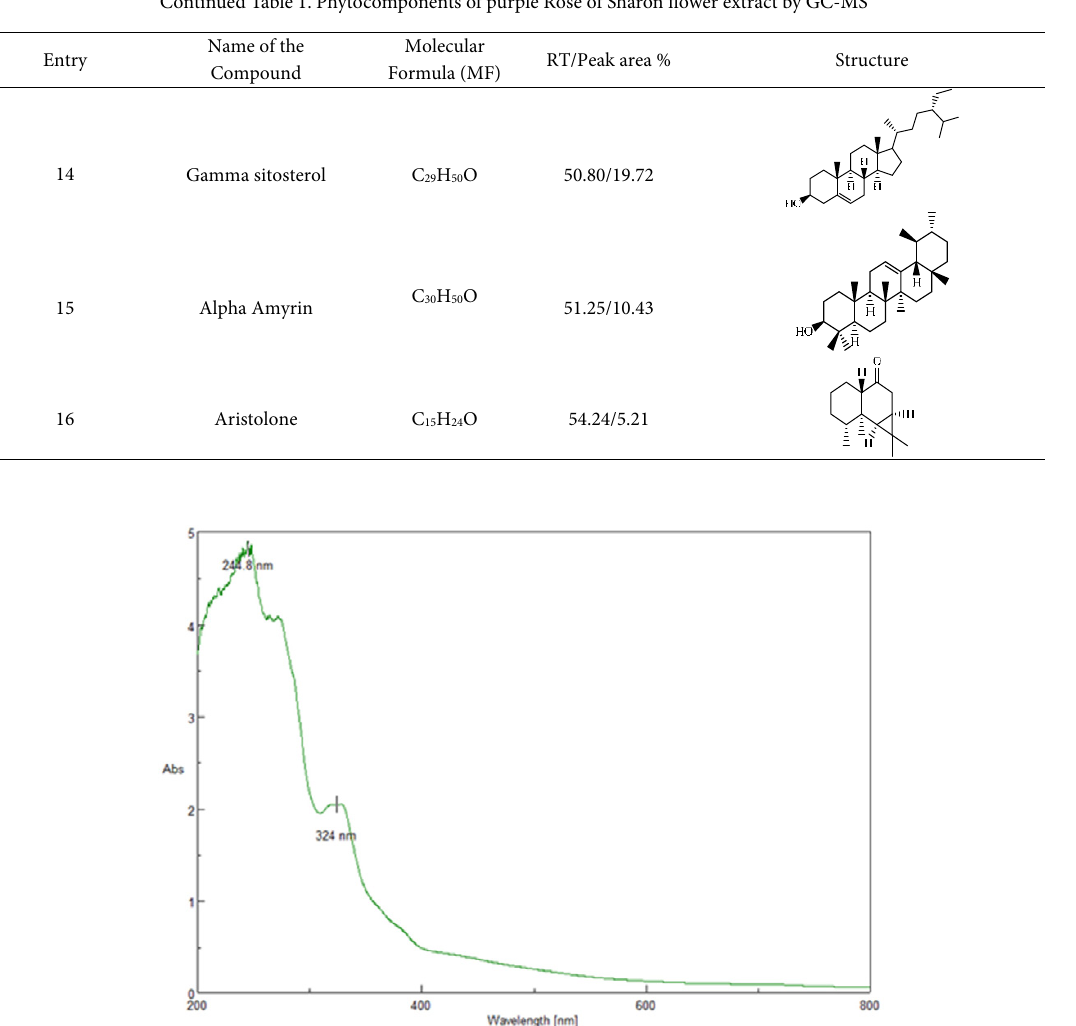
O after 24h with the ratio of Sm(NO ) : Rose of Sharon flower extract 2 3 3 3 flower extract (1:1)